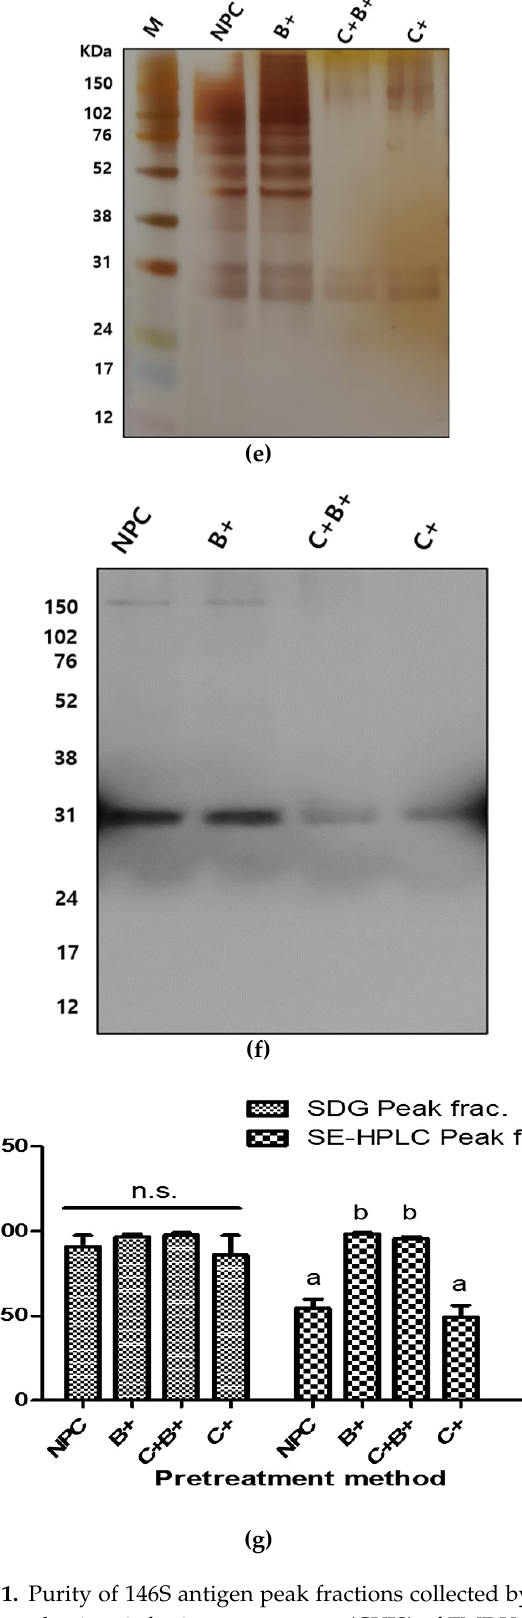
Figure 1. Purity of 146S antigen peak fractions collected by SE-HPLC from the 10 × concentrates for the crude virus infection supernatant (CVIS) of FMDV O SKR/Boeun/2017: ( a ) original chro- matograms from the SE-HPLC of CVIS (10 × ) without pretreatment (NPC); ( b ) original